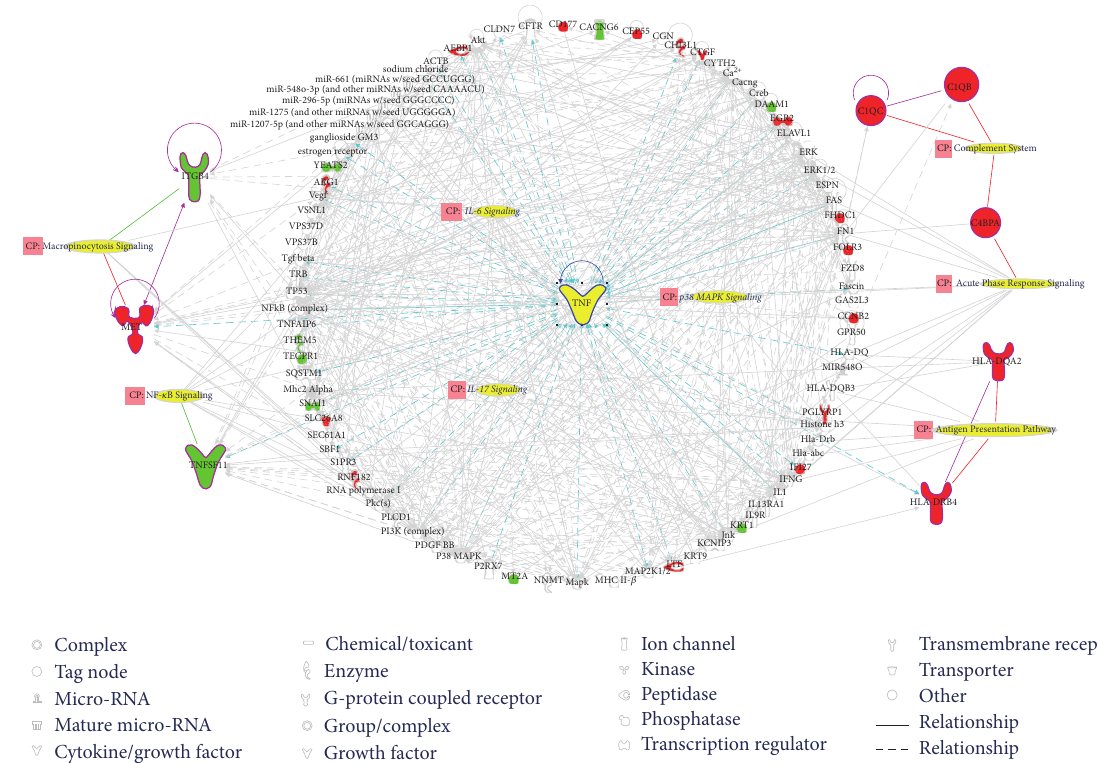
Figure 4: The most significantly relevant pathways and highly linked molecules relevant to the merged bionetwork. In the network, molecules are represented as nodes, and the biological relationship between two nodes is represented as a line. Red symbols represent upregulated DEGs; green symbols represent downregulated DEGs. Yellow symbols indicate the highly linked molecules and signaling pathways from the Ingenuity Knowledge Database. “CP” is an abbreviation of “canonical pathway,” which represents signaling pathways related to the merged bionetwork. Solid linesbetween molecules showa direct physical relationshipbetween molecules, whereas dash linesshowindirectfunctional